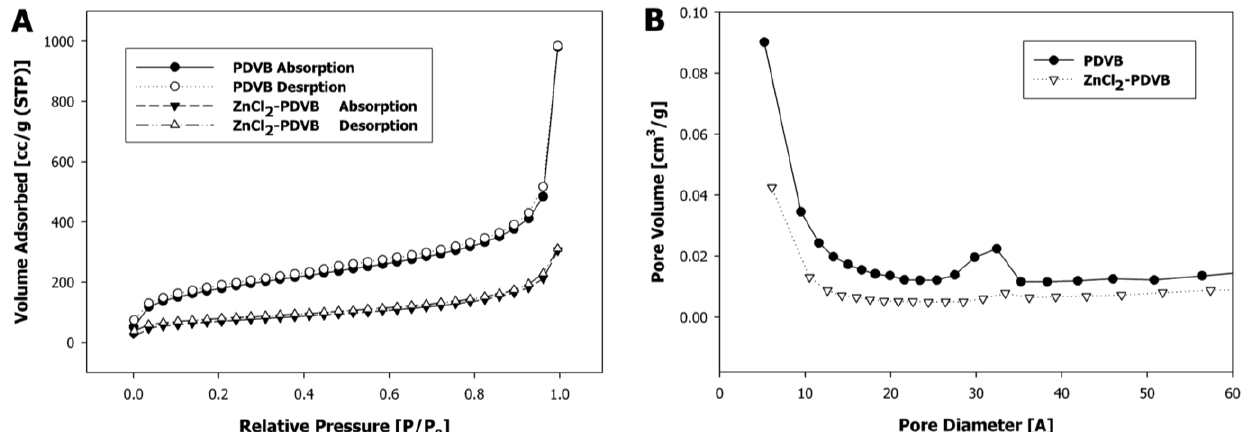
Figure 7. Porous PDVB microspheres before and after ZnCl adsorption-desorption isotherms; distribution curves.